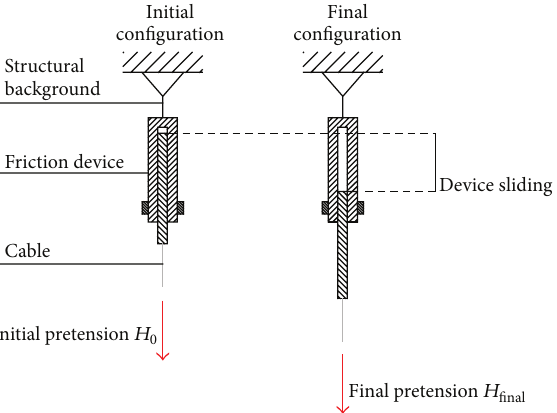
Figure 4: Frictional device and working scheme